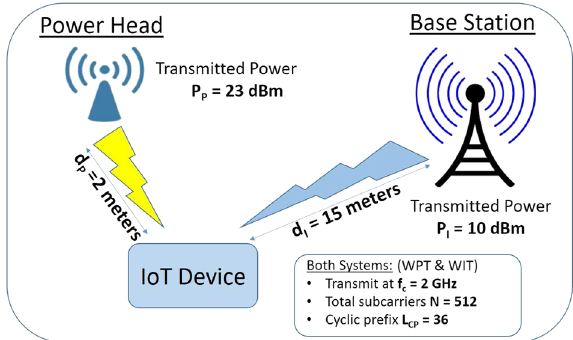
Fig. 3 Practical example of an heterogeneous network used with a power head, a base station, and an IoT receiver located 15 m away from the base-station and 2 m only from the power head. For example in an indoor scenario, the power head is in the same room as the IoT receiver while the base-station can be in a different